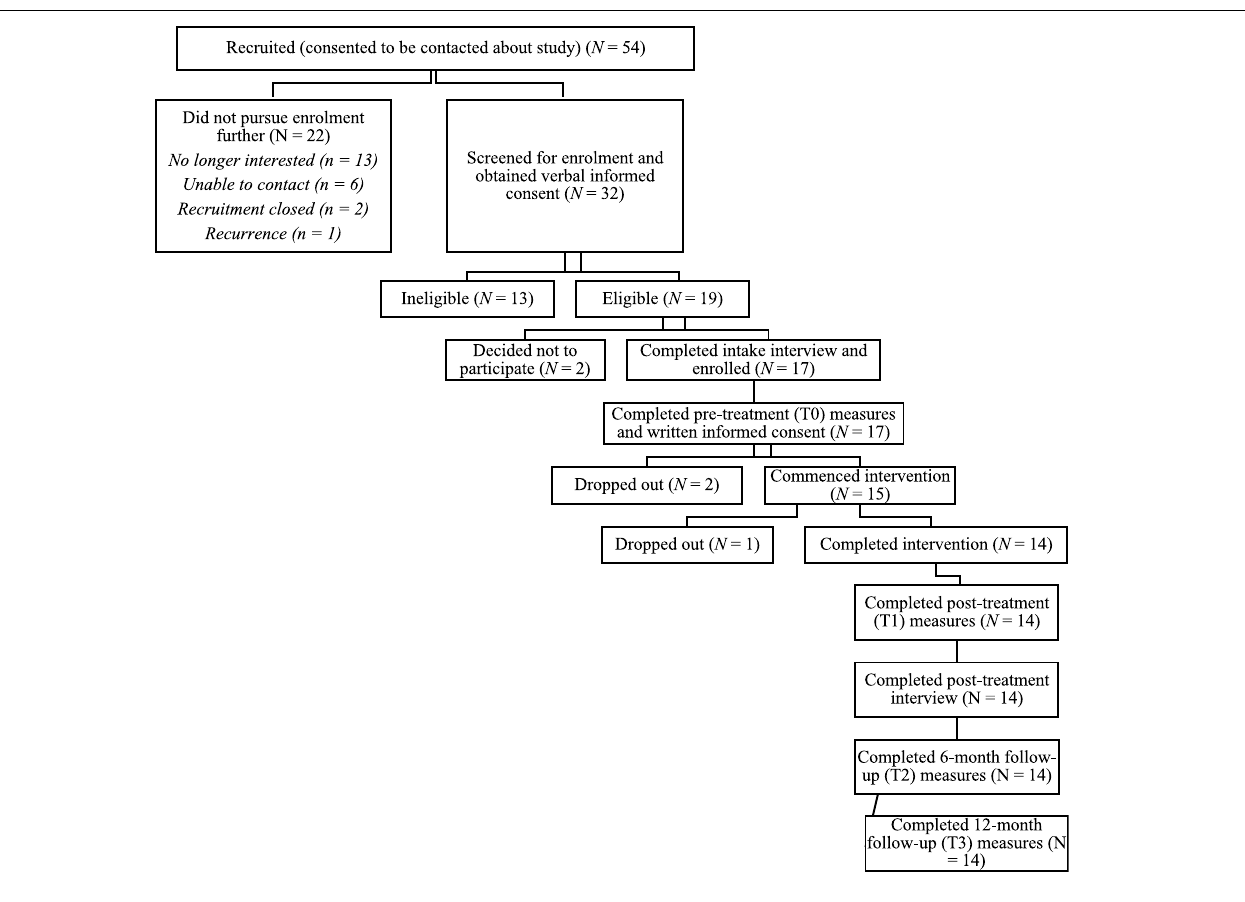
FIGURE 1 | Participant recruitment and retention